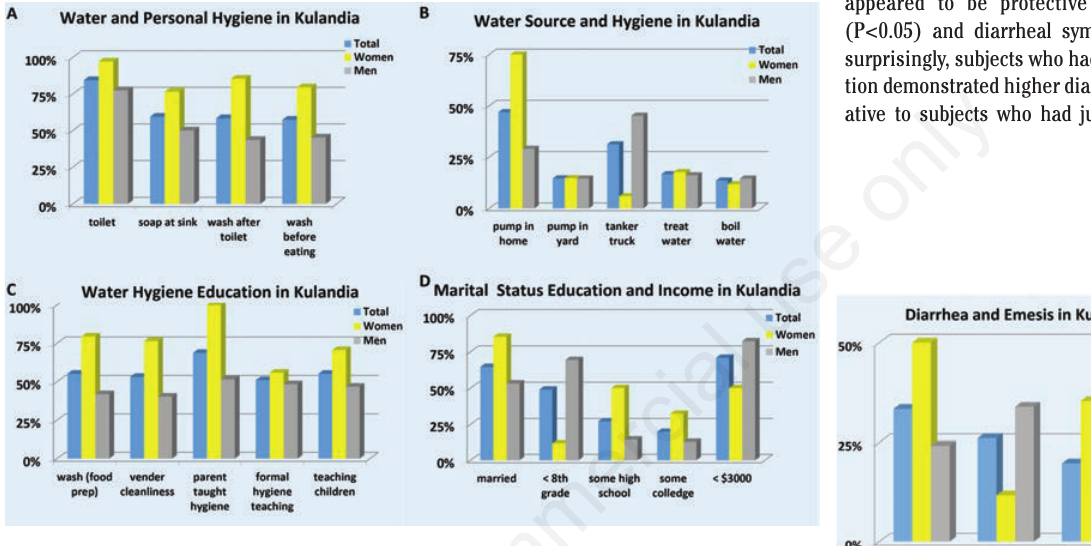
Figure 2. Distribution of emesis and diar- rhea in study